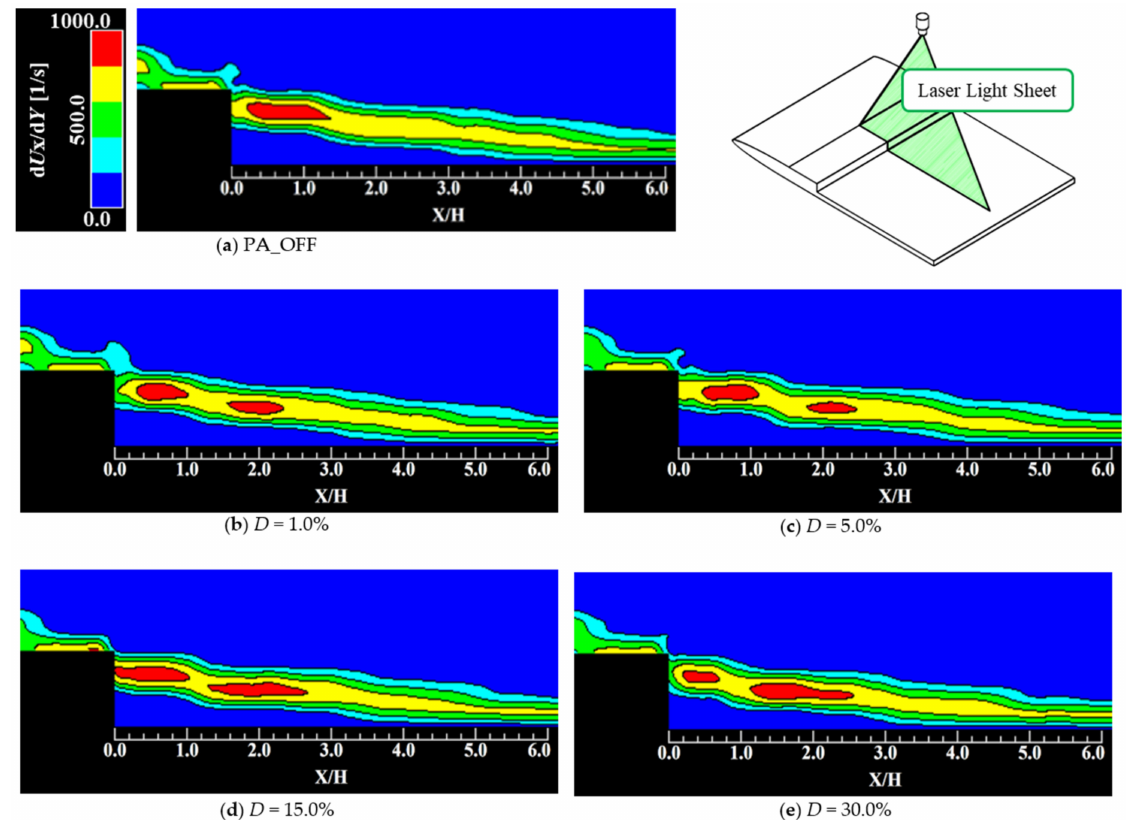
Figure 24. Iso-d U x/d Y map (PIV results using dry snowflakes as